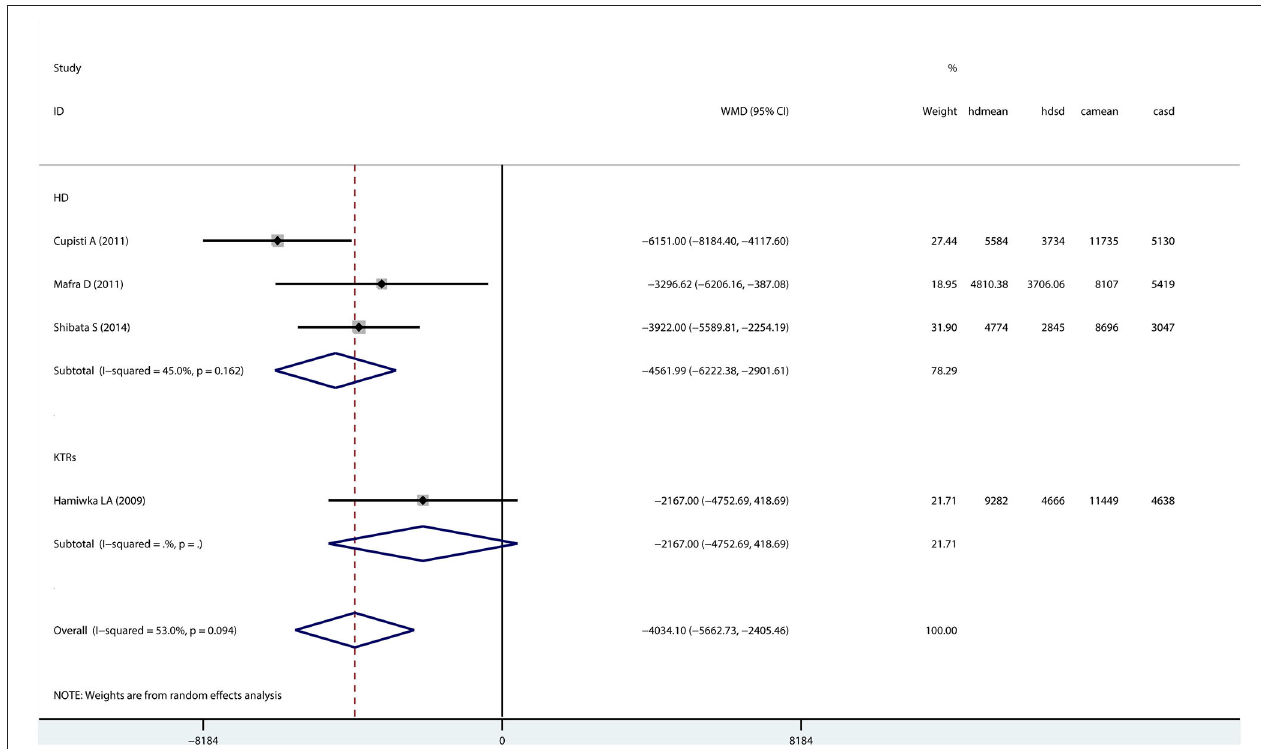
FIGURE 4 | Forest plot of the overall step counts by CKD patients and healthy